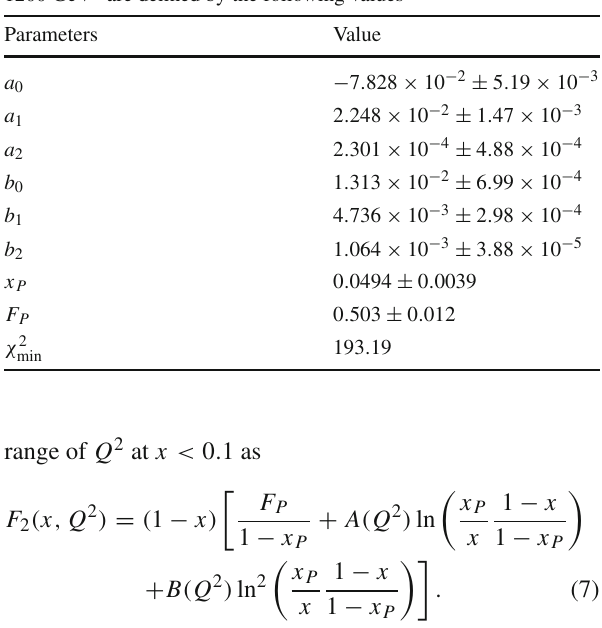
Here, x P is an approximate fixed point observed in the data ( x , Q 2 ) for different Q 2 cross. Also, where curves of F p 2